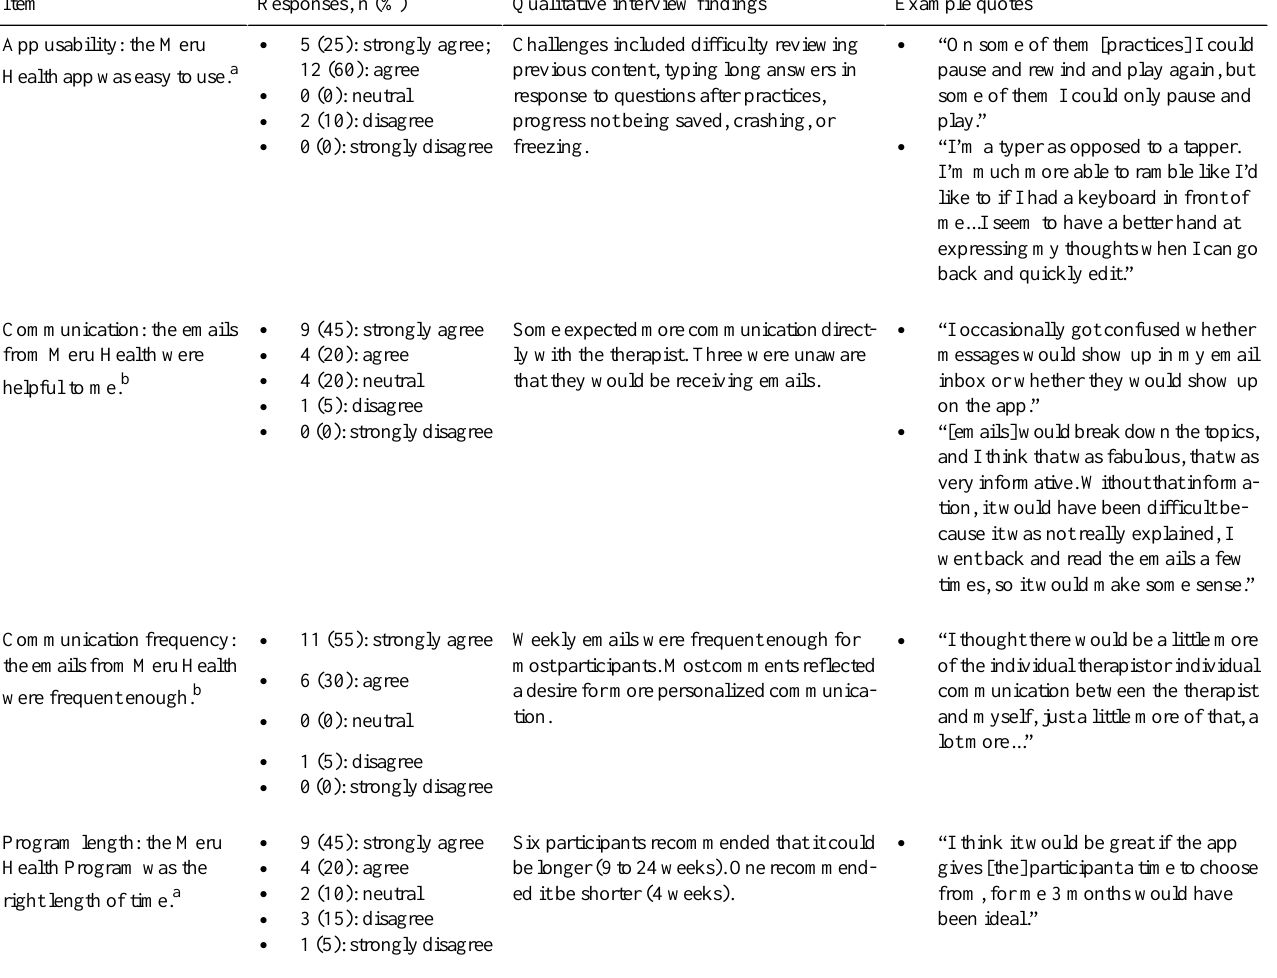
Example quotesQualitative interview findingsResponses, n (%)Item